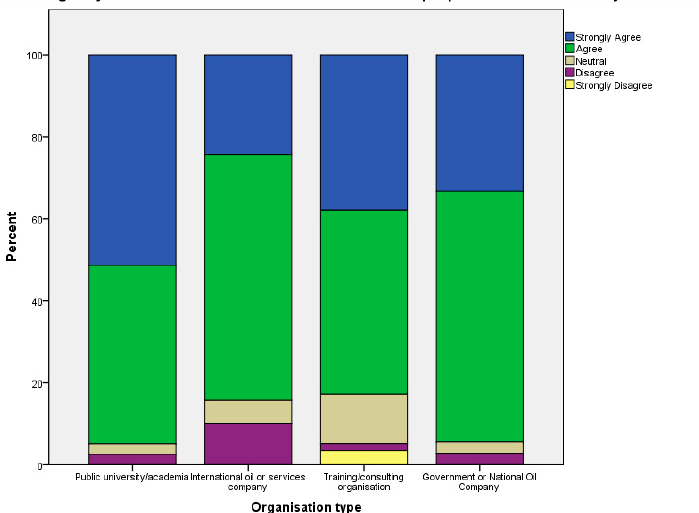
Figure 4. Responses by organization type to “investing early in local education institutions will ensure local people are trained to industry standards”.